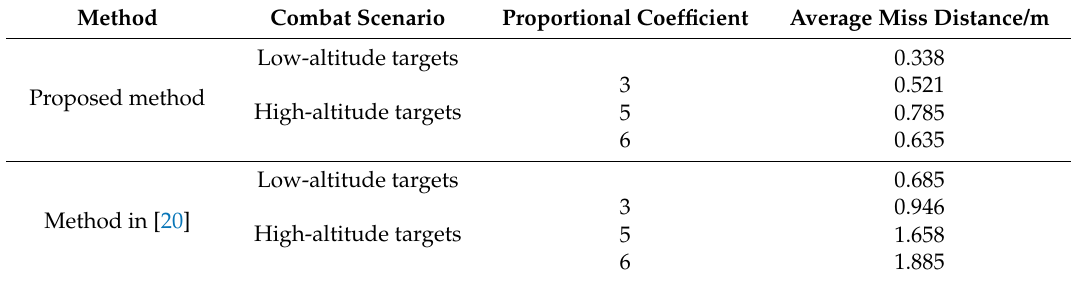
Table 2. Monte Carlo